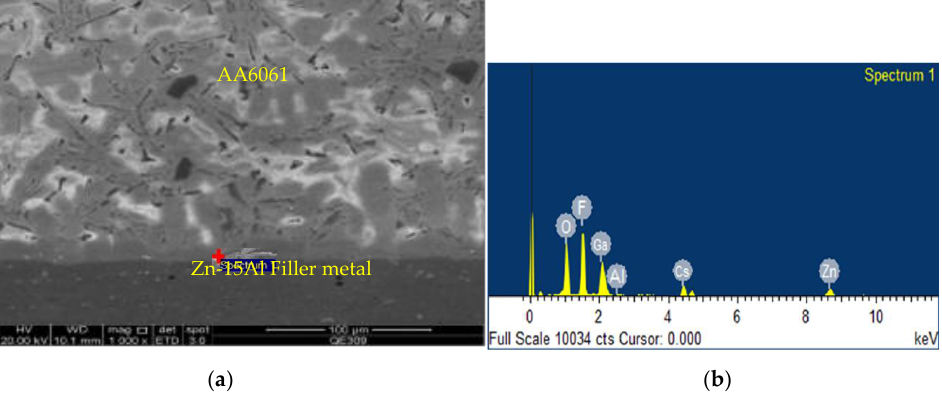
Figure 4. EDX results of the interface of AA6061 and Zn-15Al filler metal: ( a ) SEM scanning image; ( b ) EDX results of the section.